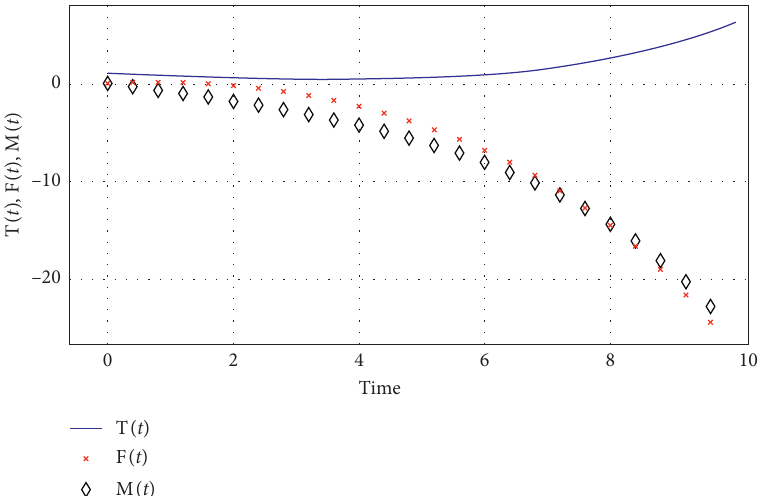
Figure 3: Behavior of the T ( t ), F ( t ), and M ( t ) for Case 3 of the TFM